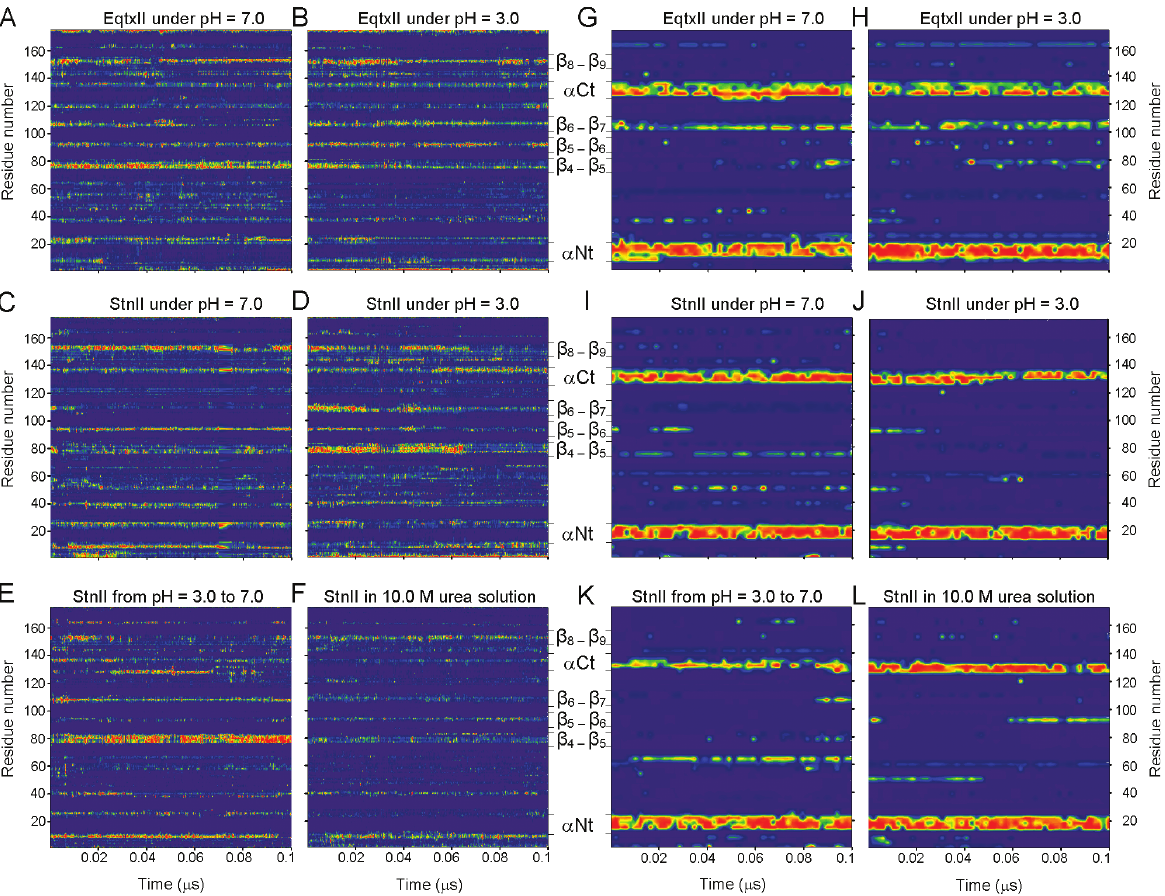
Figure 5 - All-atom RMSF from 0.06 to 0.14 nm for Systems 1 (EqtxII under pH = 7.0, A ), 2 (EqtxII under pH = 3.0, B), 3 (StnII under pH = 7.0, C), 4 (StnII under pH = 3.0, D), 5 (StnII under pH = 7.0 starting from the last frame of the simulation at pH = 3.0, E ), and 6 (StnII in 10.0 M urea solution, F); and ellipticity from 0 to 80 % at 222 nm ( percentage of time in which the residues present a helical nature ) for Systems 1 (G), 2 (H), 3 (I), 4 (J), 5 (K), and 6 (L) . Both analyses range from blue to red according with the increase in flexibility or helical